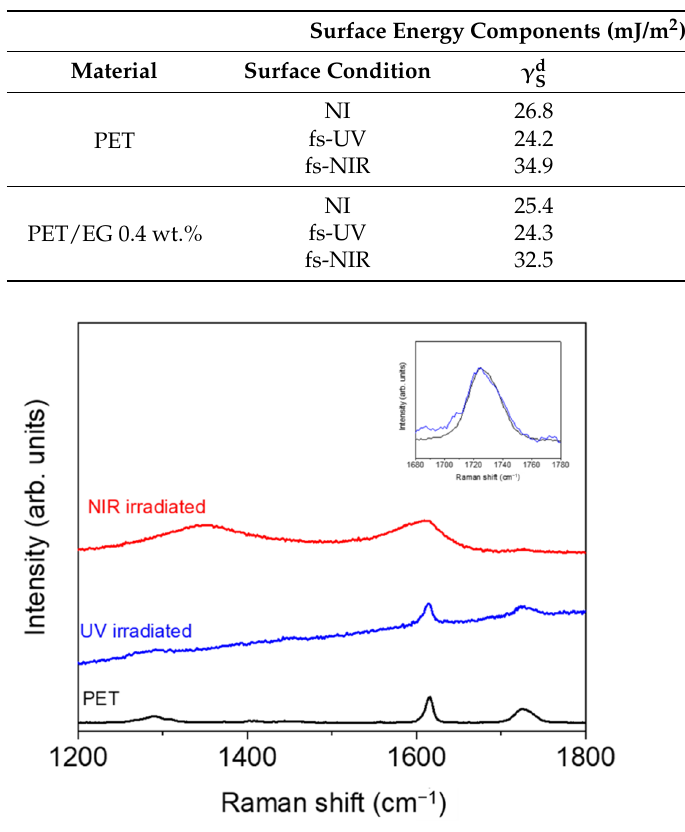
Table 3. Surface energy and its components (mJ/m 2 ) calculated by using the OWRK method of non-irradiated (NI) and irradiated (fs UV and fs NIR pulses) on PET and PET/EG 0.4 wt.% surfaces obtained from the average data listed in Table 2. The errors were estimated at ca. 10%.